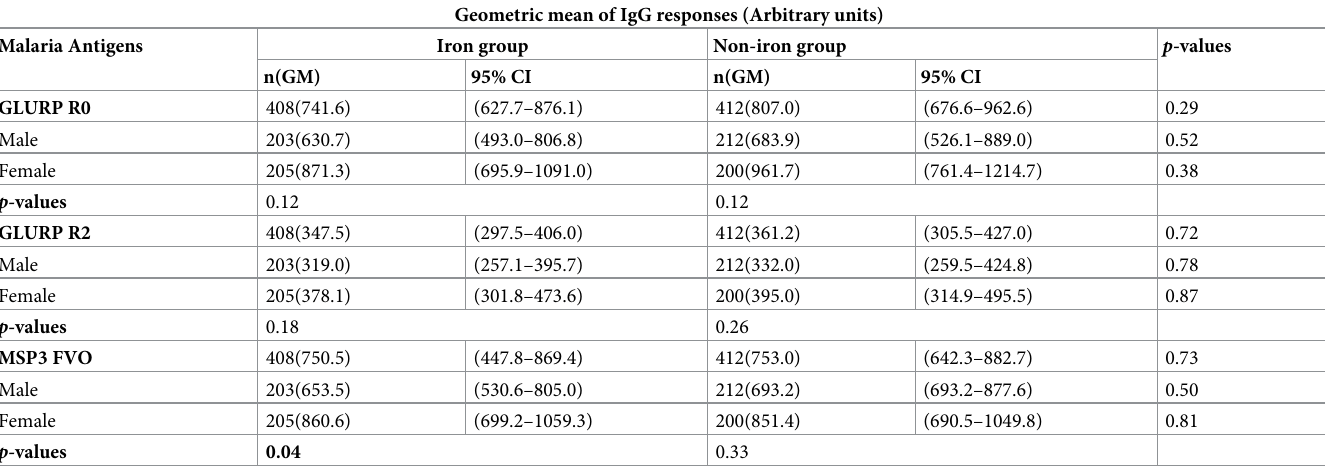
Table 2. Effect of iron fortification on malaria antigen-specific IgG